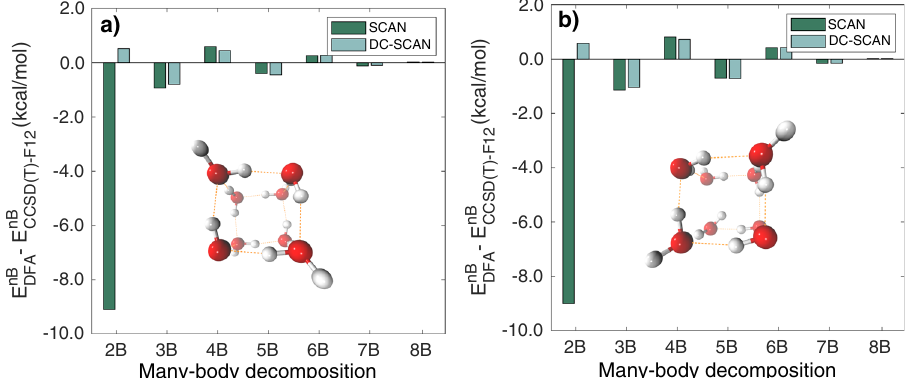
Fig. 3 Errors in n B interaction energy of water octamers. Errors relative to CCSD(T)-F12b reference values for each n B energy contribution to the interaction energies calculated for the two isoenergetic isomers, a D 2d and b S 4 , of the water octamer using the SCAN and DC-SCAN